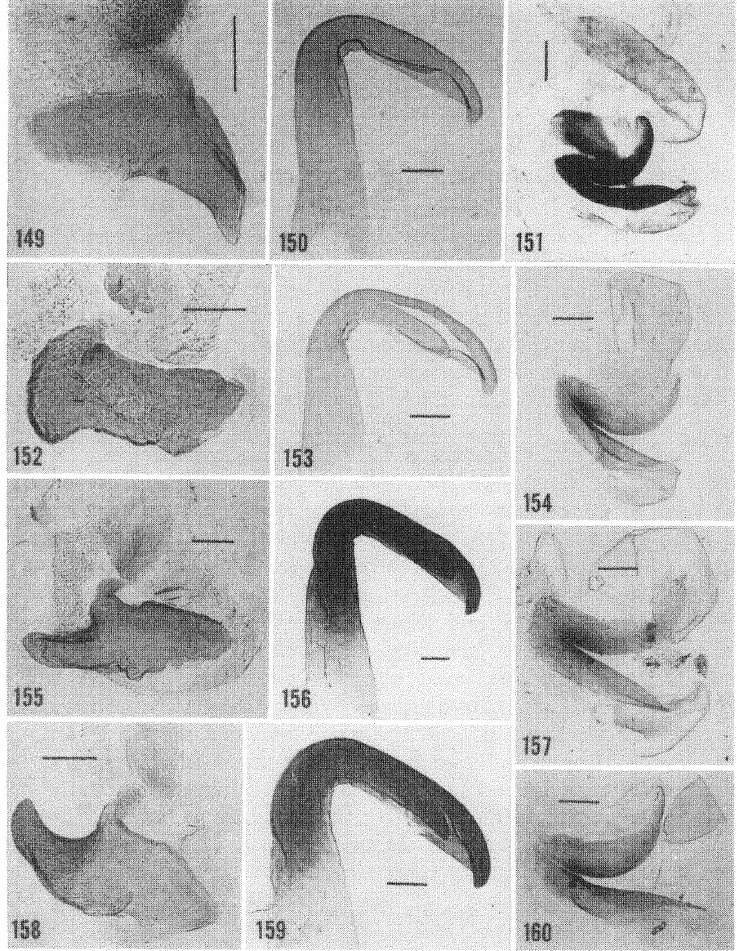
Figures 149-160. Male genital phallomeres of Zuluia spp. 149-151. (1408 L). Z. lithostrota (from shown in Fig. 145). 152-154. (154 ANSP). Z. lubescens (from $ shown in Fig. 146). 155-157. (1407 L). Z. abscissa (from $ shown in Fig. 148). 158-160. (145 ANSP). Z. abscissa (from $ shown in Fig. 147). (scale-- 0.1